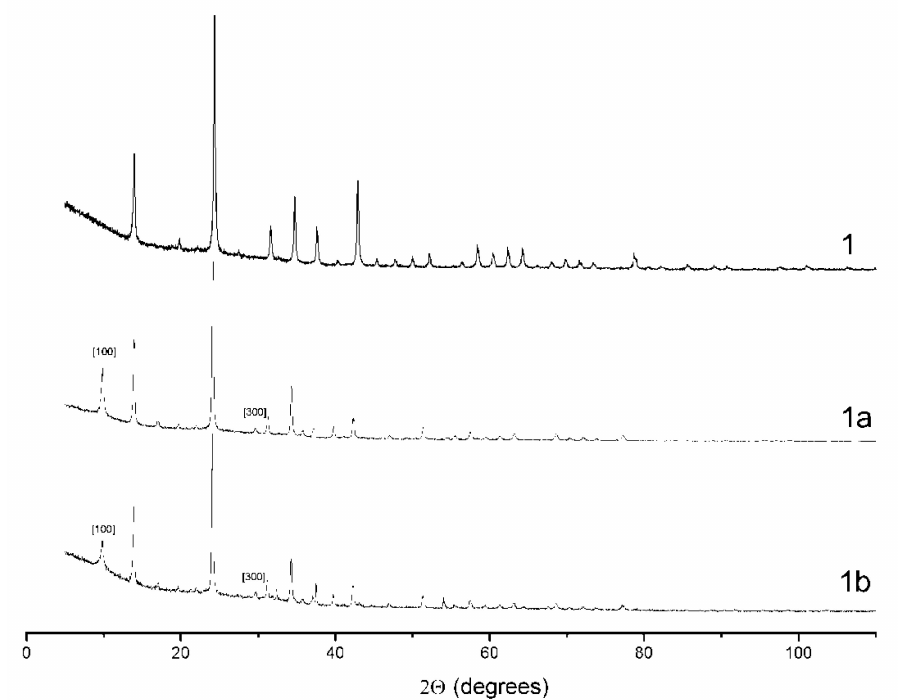
Figure 28. Powder X-ray diffraction patterns of the products of Experiments 1, 1a and 1b. All reflections correspond to sodalite-type phases [the space groups P -43 n (Experiment 1) and P23 (Experiments 1a and 1b)]. The reflections [100] and [300] are marked as indicative for P 23 space